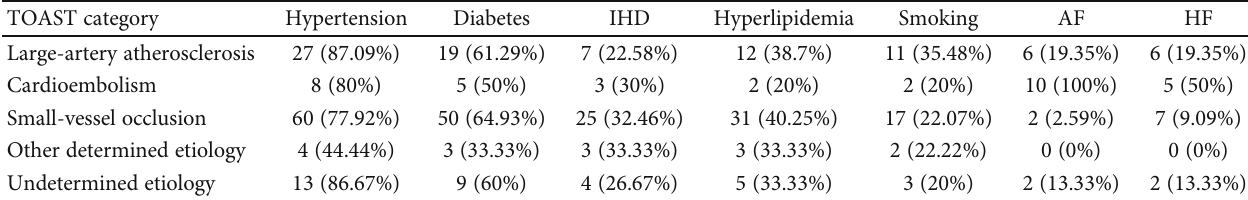
Table 4: Prevalence ( n ) and percentage (%) of stroke risk factors for each stroke category. Abbreviations: Ischemic heart disease: IHD; atrial fi brillation: AF; heart failure: HF.